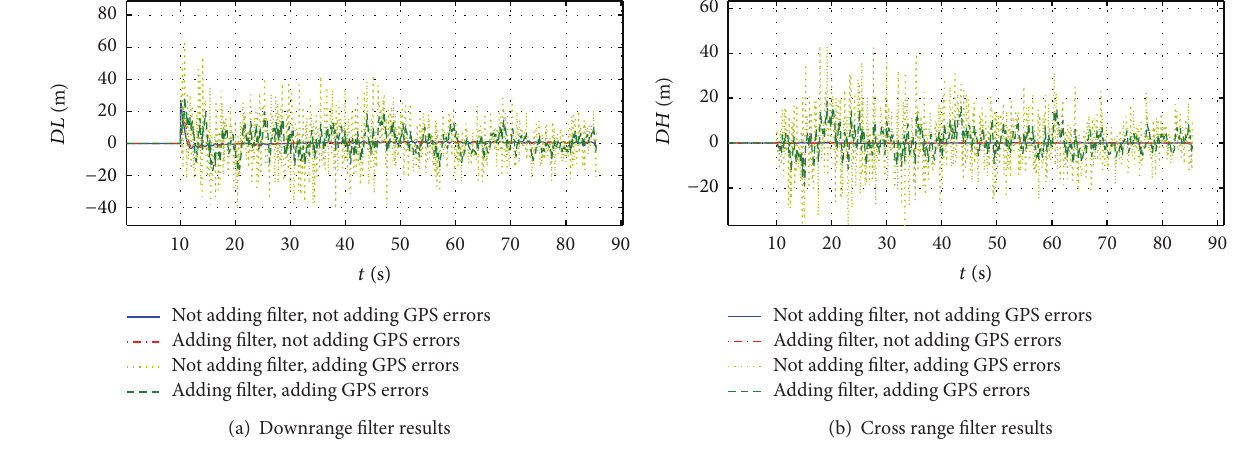
Figure 10: Results of second-order fading memory